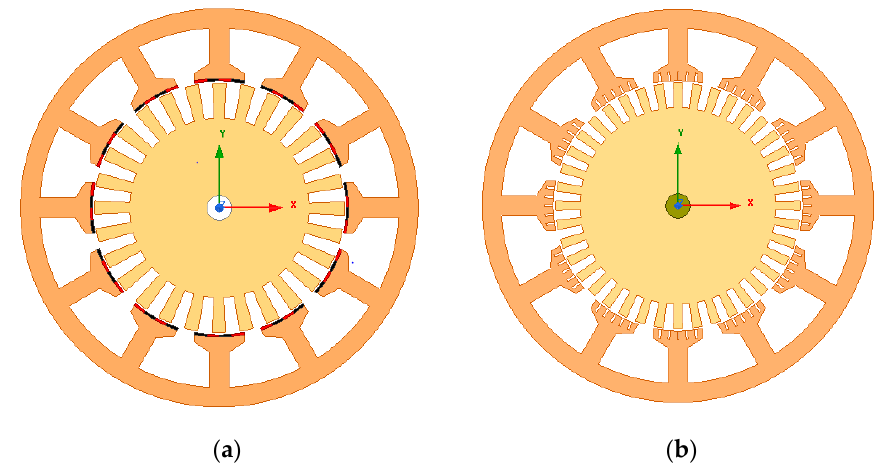
Figure 6. Various pole and PM arrangements of the FRM machines [23]; ( a ) PMs on stator pole; ( b ) inset PMs on stator.